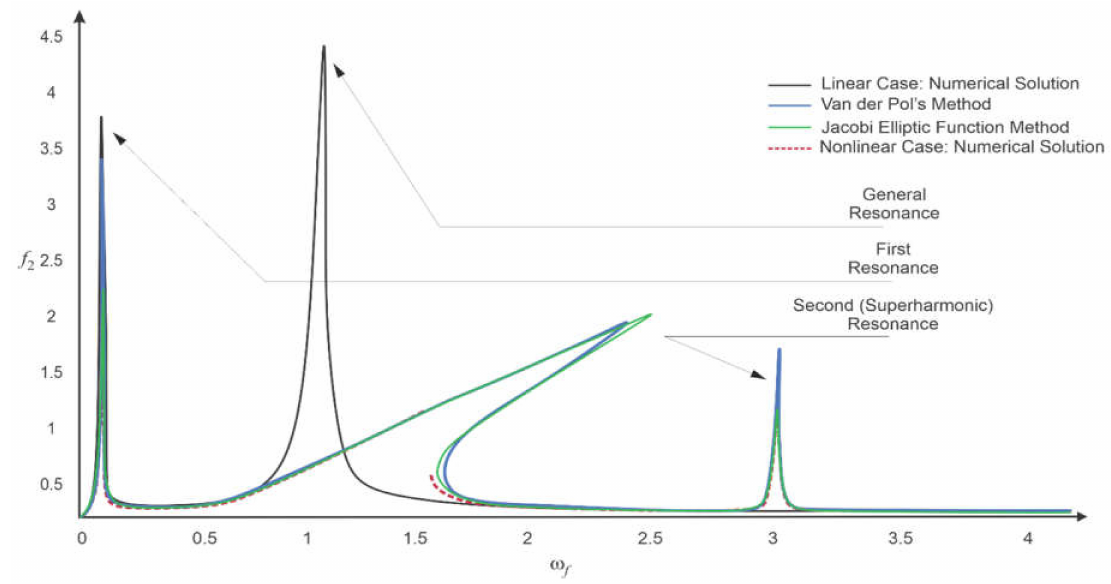
Figure 4. The amplitude-frequency characteristic of the foundation.